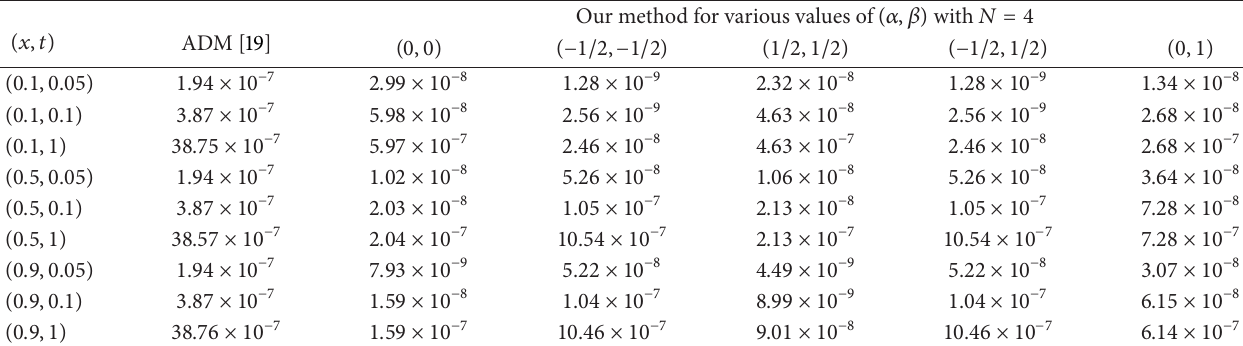
Table 1: Comparison of absolute errors of Example 1 with results from different articles, where 𝑁 = 4 , 𝛾 = 10 −3 , and ] = 𝜂 = 𝛿 = 1 .